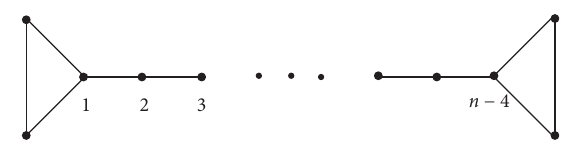
Figure 1: The extremal graph attaining the upper bound in Proposition